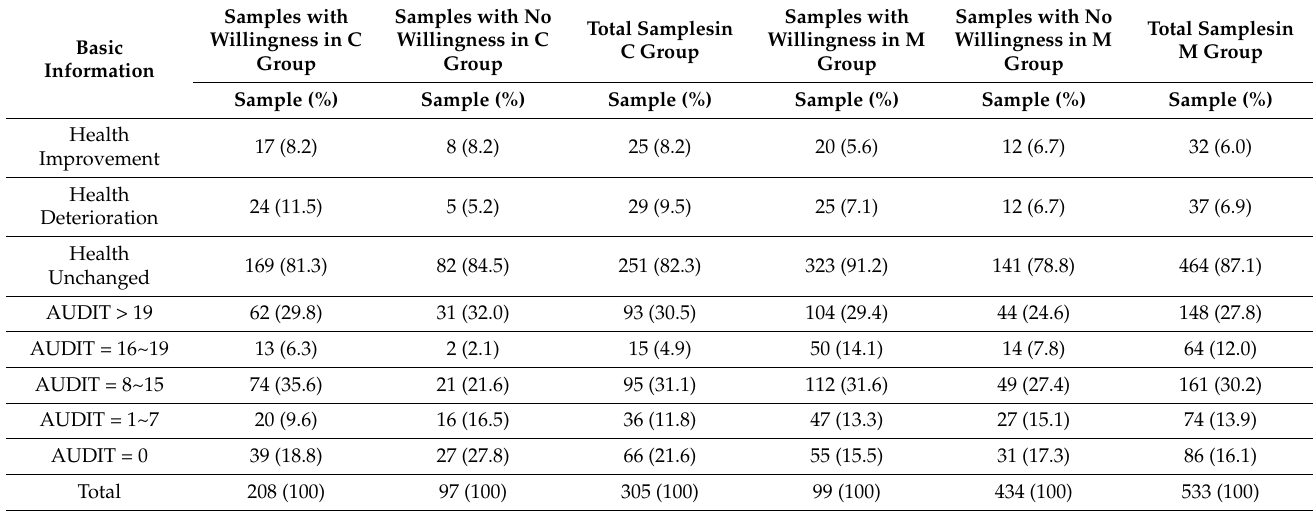
Table 5. Drinking pattern and self-health assessment statistics.